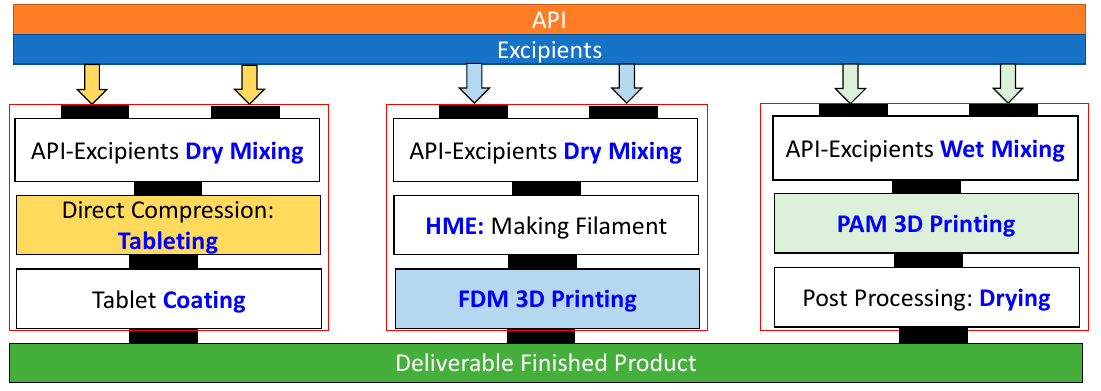
Figure 4. Comparison of different processing steps required for traditional direct compression (DC) tablet manufacturing vs. advanced manufacturing, 3D printing (FDM or PAM).